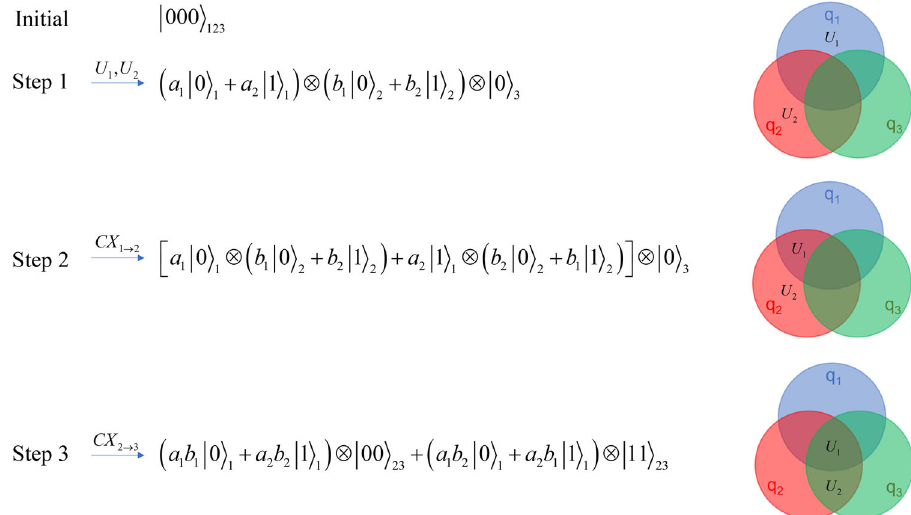
Fig. 1 The creation and copying of unitary dependences. The fi gure shows the unitary dependence creation by 1-qubit unitaries and copying by CNOT gates. The state at each step is described by a Venn diagram that shows how unitary dependences are shared among the qubits. The unitary dependences a 1 are created by the 1-qubit unitaries U 1 ¼ U 1 ð a 1 ; a 2 ; α Þ ¼ ð j b 1 j 2 þ j b 2 j 2 ¼ 1). Then the dependences are copied by the CNOT gates CX 1 ! 2 and CX 2 ! 3 to the appropriate qubits. At the fi nal Step 3 we have U 2 shared by q 2 and q 3 , and U 1 shared by all three